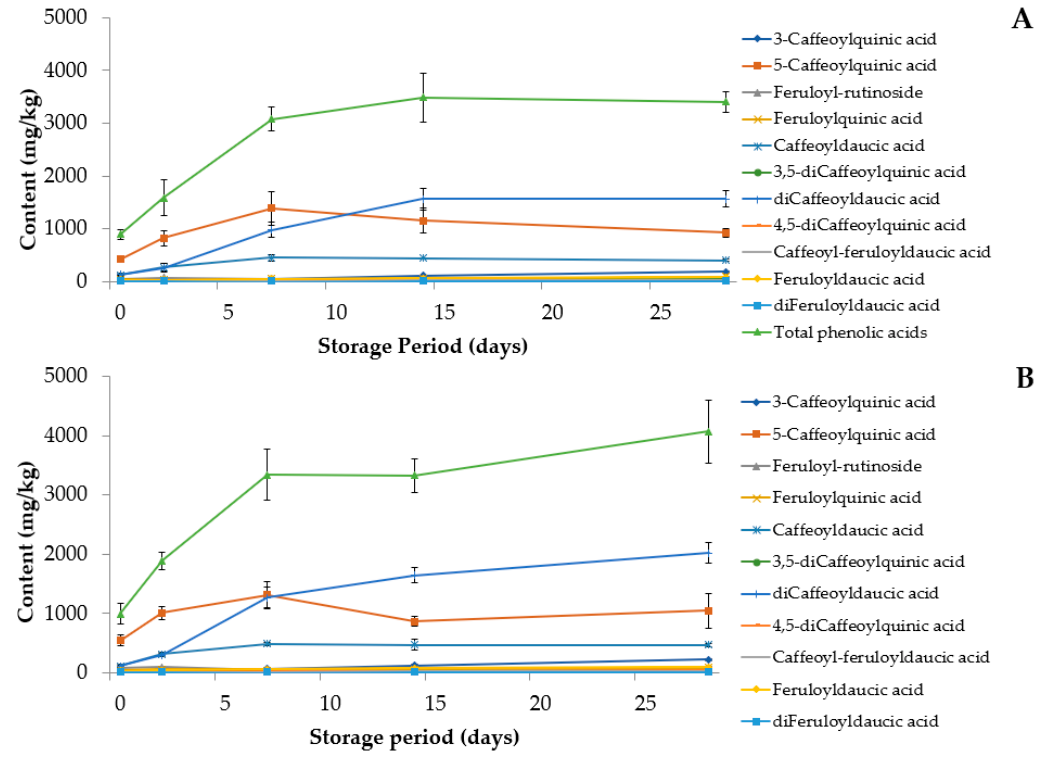
Table 2. Initial contents of phenolic acids in untreated, washed, polished, peeled and grated carrots (mg/kg DW). Carrot Sample Phenolic Acid Untreated Washed Polished Peeled Grated Peels 3-Caffeoylquinic